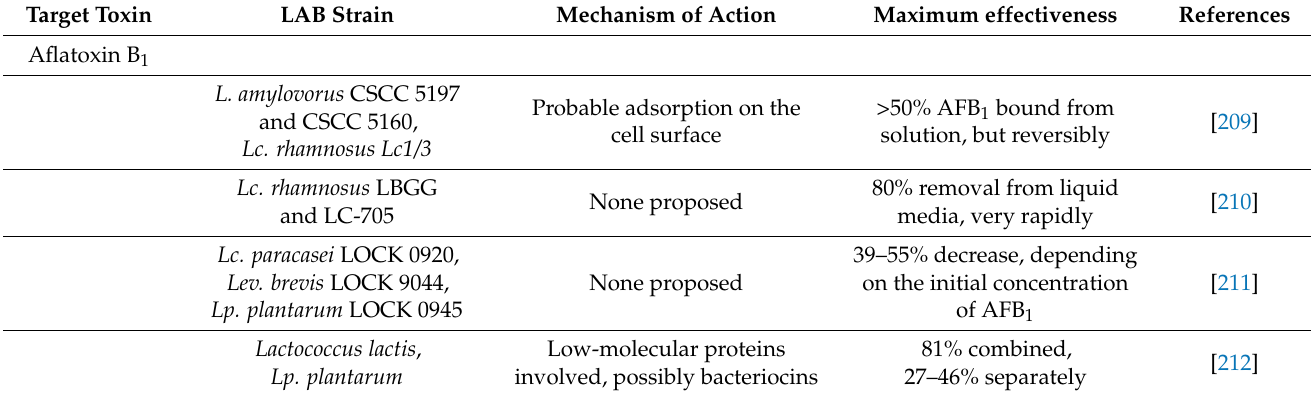
Table 6. Major studies of LAB-mediated mycotoxin-related